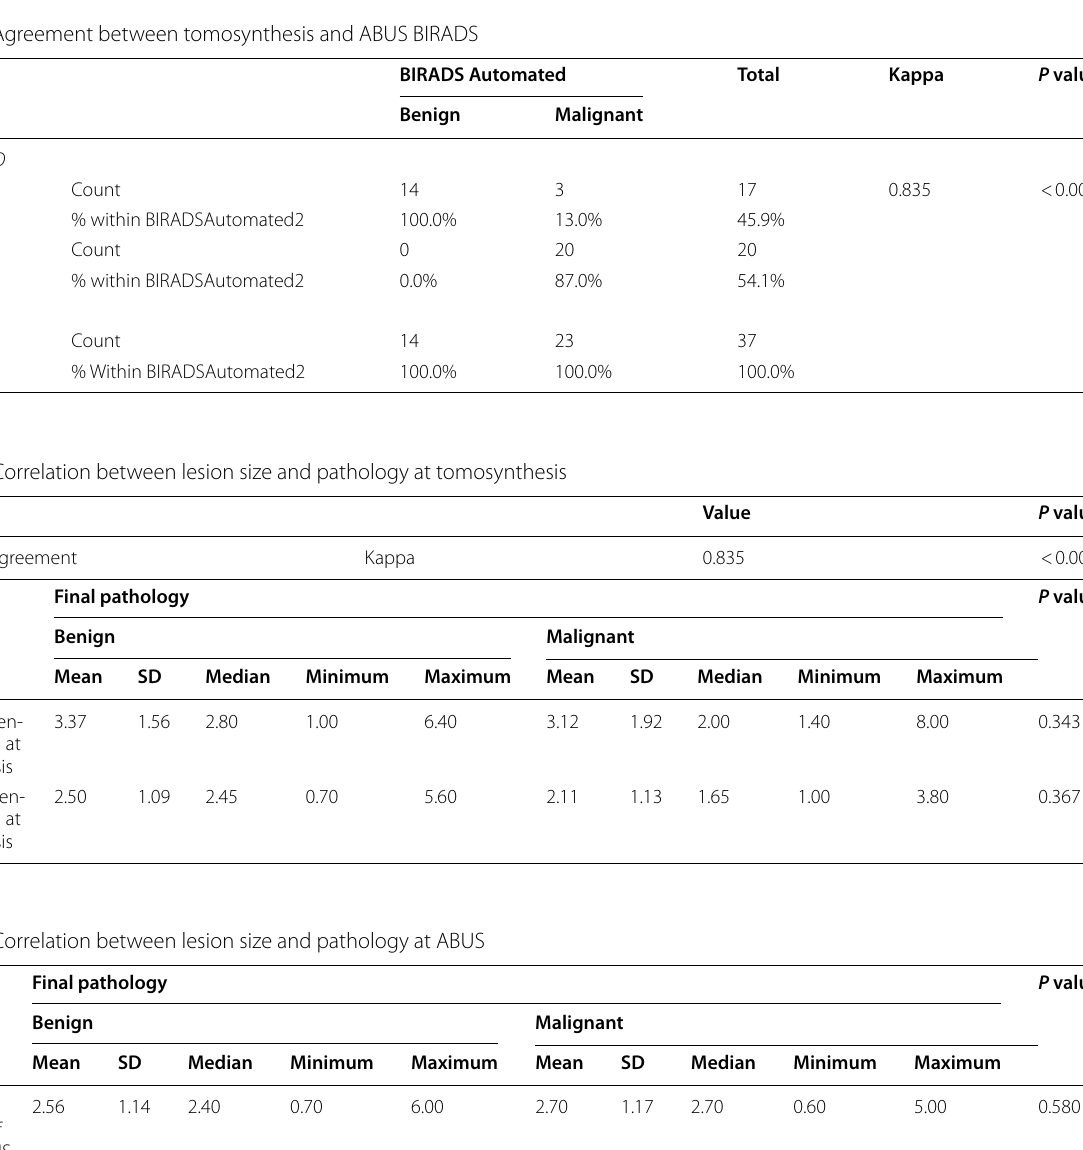
Table 10 Agreement between tomosynthesis and ABUS BIRADS